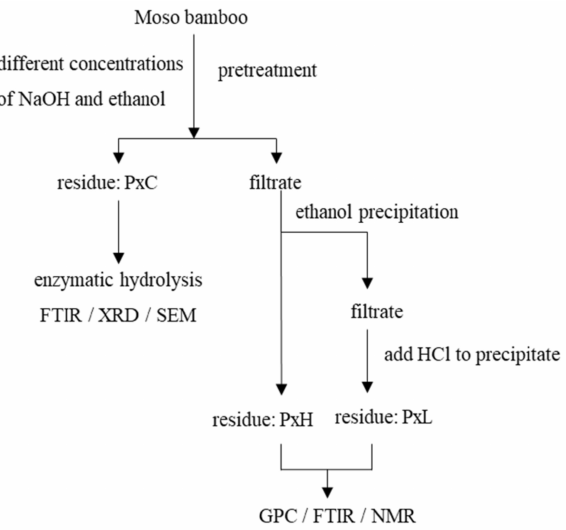
Figure 1. Experimental and analytical flow chart of the fractionation of Moso bamboo under mild